Question: Write a single sentence explaining what this figure depicts.
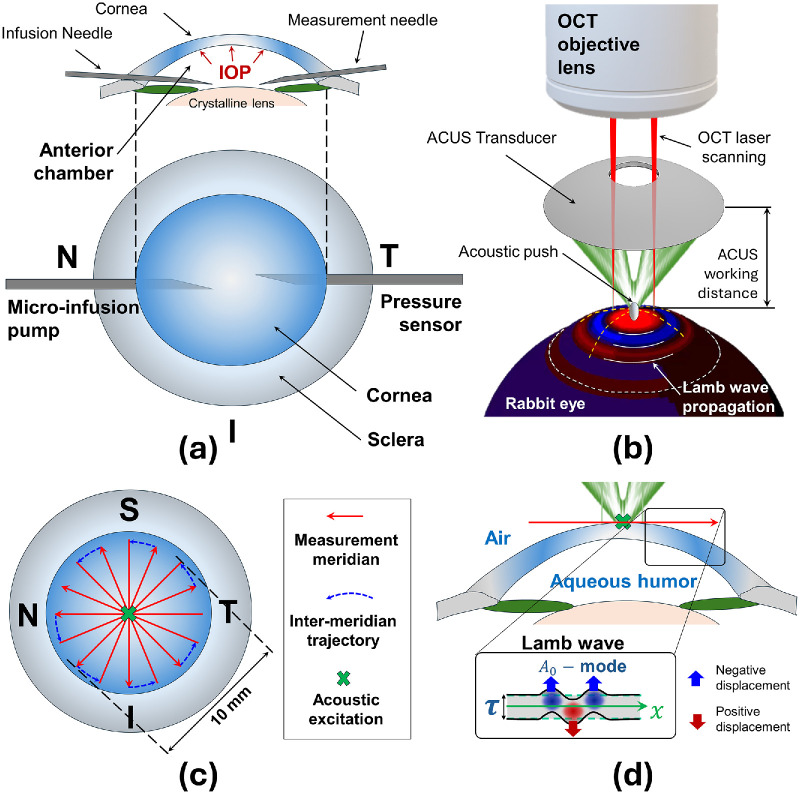
Answer: ( a ) Pressurized rabbit ex vivo eye globe using a closed loop IOP control system set to 15.0 ± 0.2 mm Hg. ( b ) ACUS-OCE system setup composed of a PhS-SS-OCT system and a 500-kHz ACUS transducer, confocal and coaligned with the OCT sample arm. The acoustic excitation is focused on the corneal apex. ( c ) Acquisition of 8 OCT meridians distributed along 360° (steps of 22.5°), forming 16 semimeridians centered at the corneal apex. ( d ) Outward antisymmetric 0-mode Lamb wave propagation along a single corneal meridian after excitation. I, inferior; N, nasal; S, superior; T, temporal.